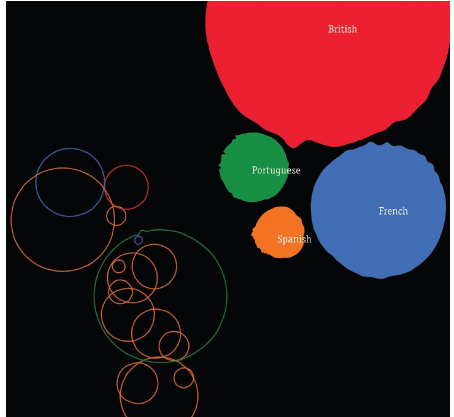
Figure 5. Cruz et al. show the British hegemony and the newly independent South America in 1891. Each empire and independent territory is a circle whose area is proportional to that entity’s land area. Former colonies are unfilled circles with rims in the corresponding empire’s color [18]. Image courtesy of Cruz et al.